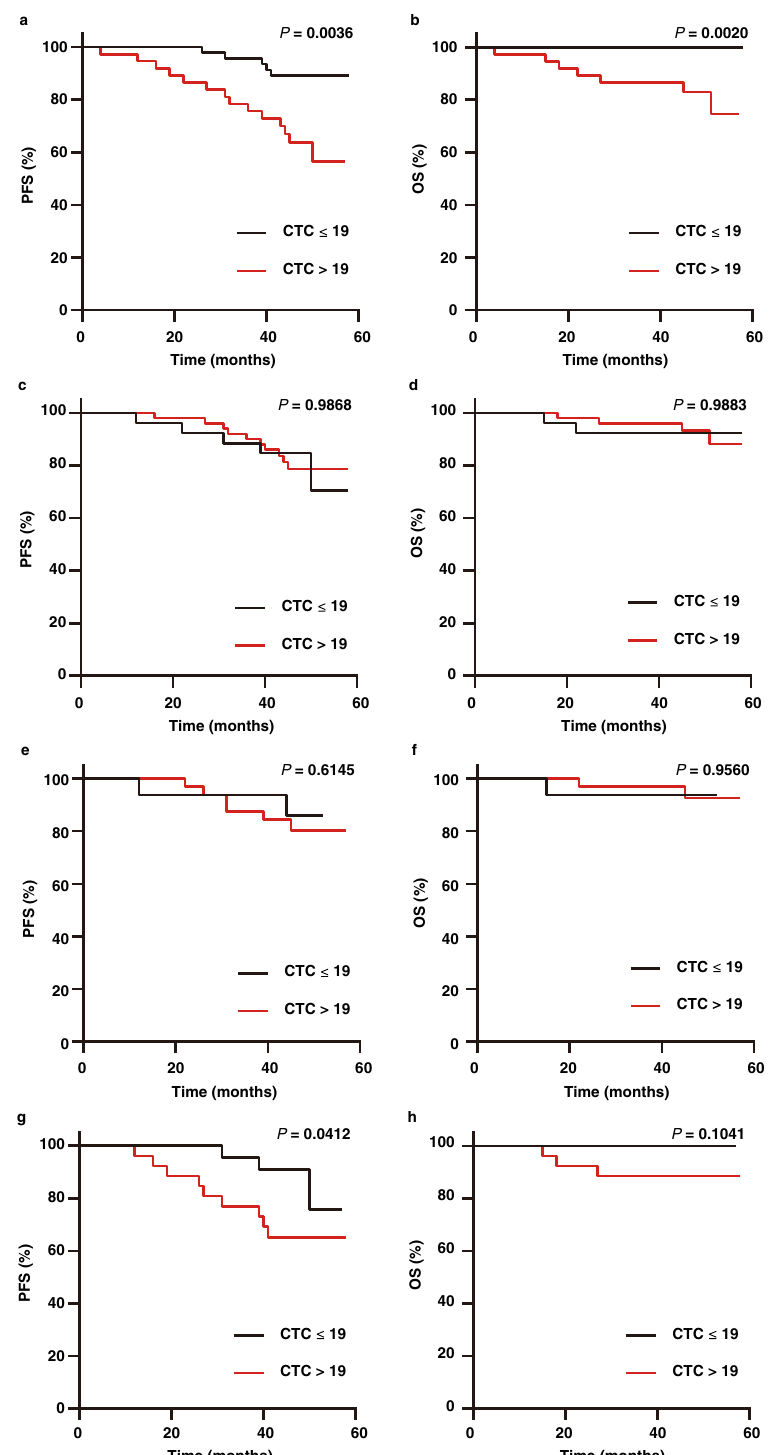
Figure 3. Kaplan–Meier curves showing estimated PFS and OS for patients with CTC negativity (CTC ≤ 19) and CTC positivity (CTC > 19) before surgery ( a , b ), 1 d after surgery ( c , d ), 7 d after surgery ( e , f ) and 14 d after surgery ( g , h